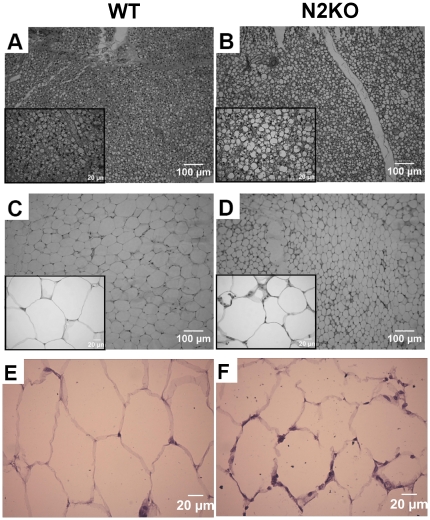
Histology and immunohistochemistry of Brown and White Adipose Tissues from N2KO and WT mice.H&E staining of Brown Adipose Tissue (A) or White Adipose Tissue (C) from WT, (B) and (D) from N2KO. Scale bars for whole and inset pictures are given. Immunohistochemistry of WAT using F4/80, a macrophage specific marker staining of WT (E) and N2KO (F).